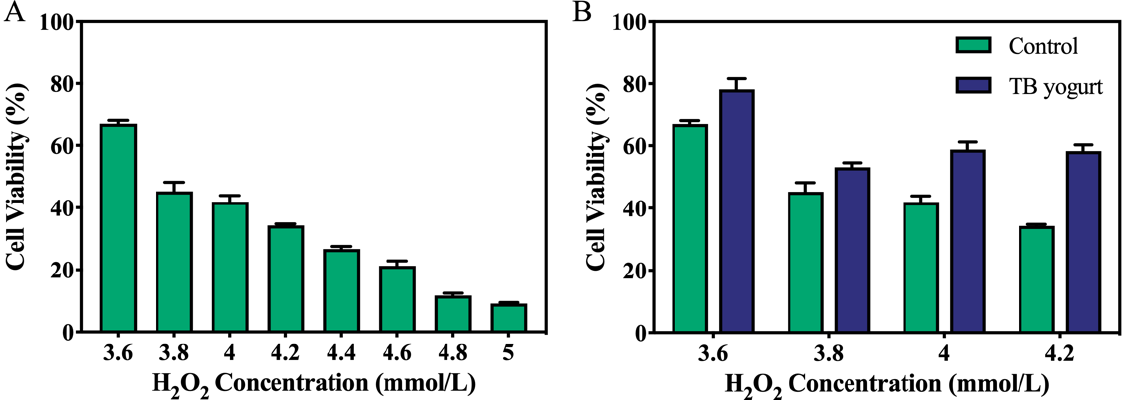
Figure 6. ( A ) IPEC-J2 cells were treated with various concentrations of H 2 O 2 (3.6–5 mmol/L); the effects of different concentrations of H 2 O 2 on IPEC-J2 cells viability were determined using the MTT assay. ( B ) Cell viability in the presence of 3.6, 3.8, 4.0, and 4.2 mmol/L H 2 O 2 . The cells were divided into the control group (marked as control) and the clear supernatant of optimized yogurt added with TB group (marked as TB yogurt). Data were presented as mean ± SD of three independent experiments.